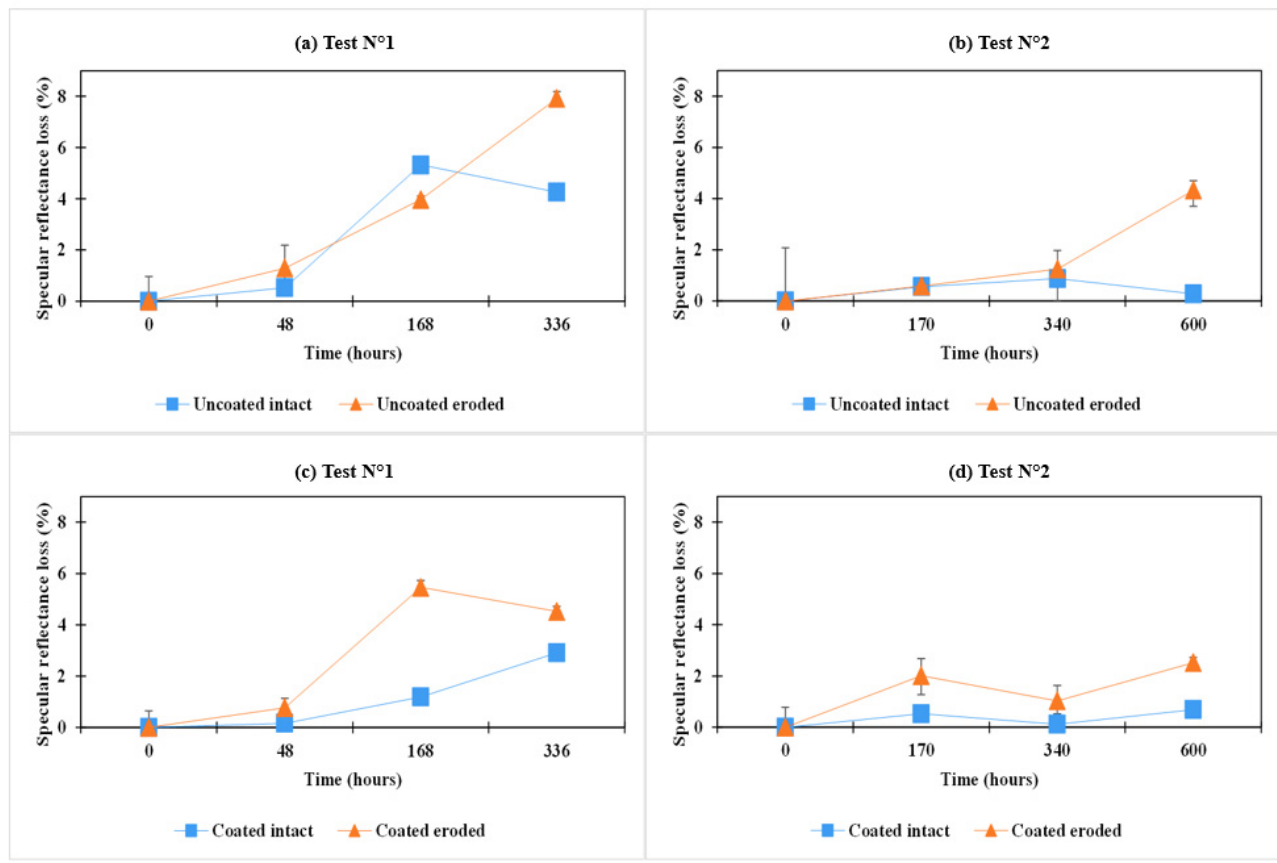
Figure 14. Specular reflectance loss of tested samples.